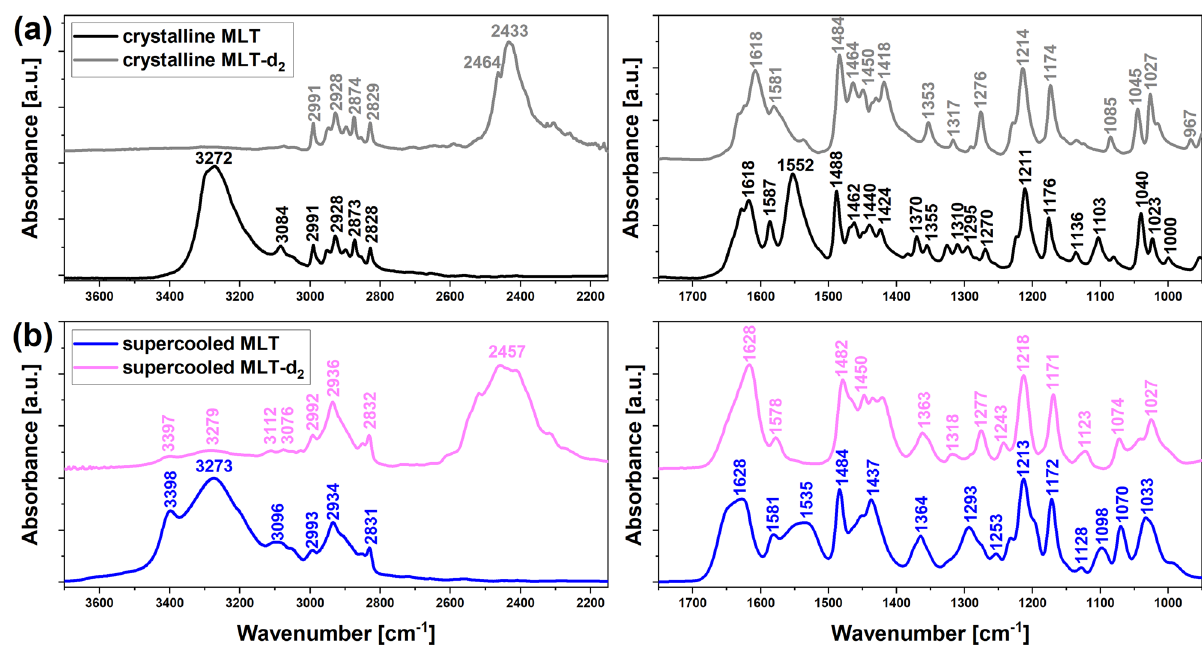
Figure 1. Infrared spectra of ( a ) crystalline MLT and MLT-d 2 as well as ( b ) supercooled MLT and MLT-d 2 , measured at 295 K. The data are presented in two spectral regions: 3700–2150 cm -1 (left) and 1800–950 cm −1